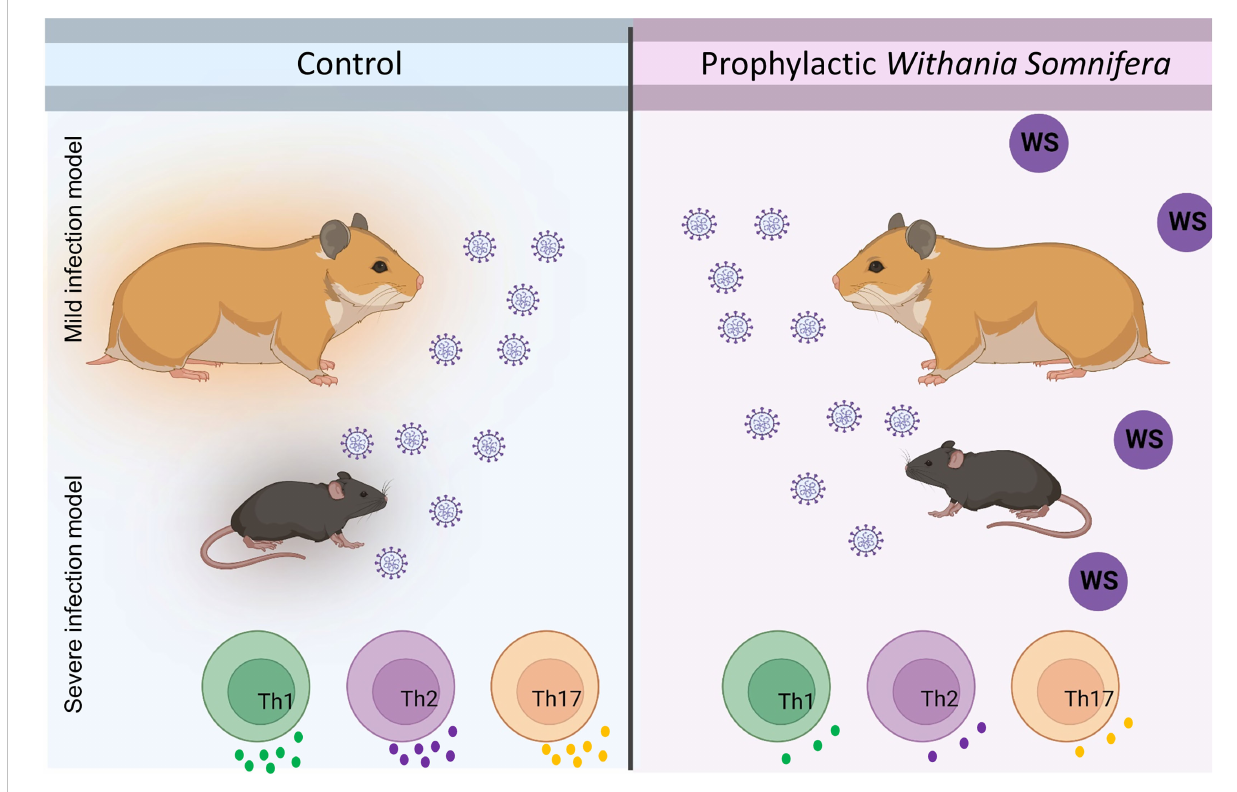
FIGURE 9 Summary fi gure highlighting the study design and novel fi ndings from the